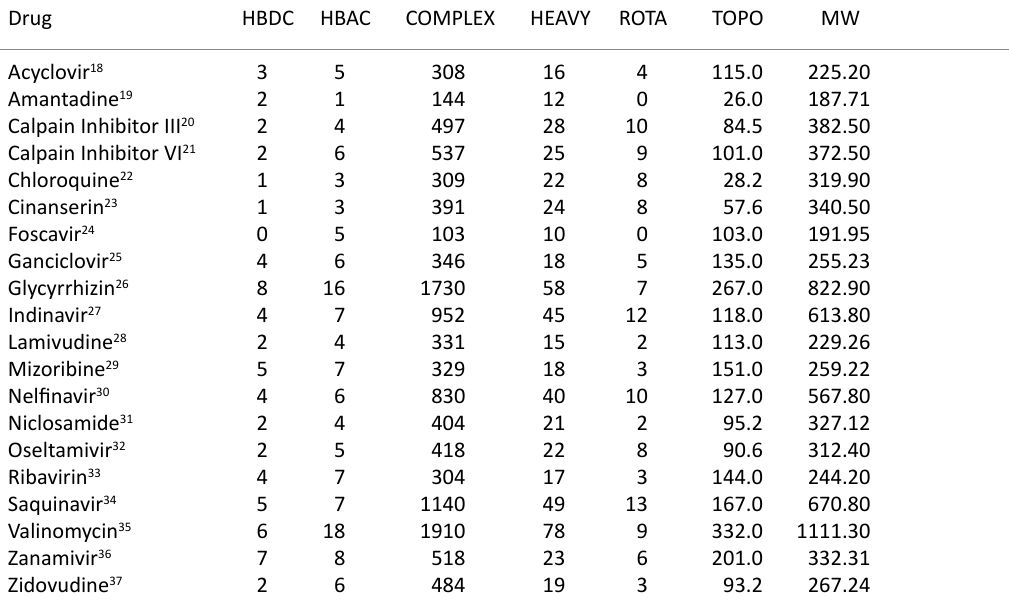
Table 1. Chemical and physical properties of potential and clinically approved antiviral drugs Drug